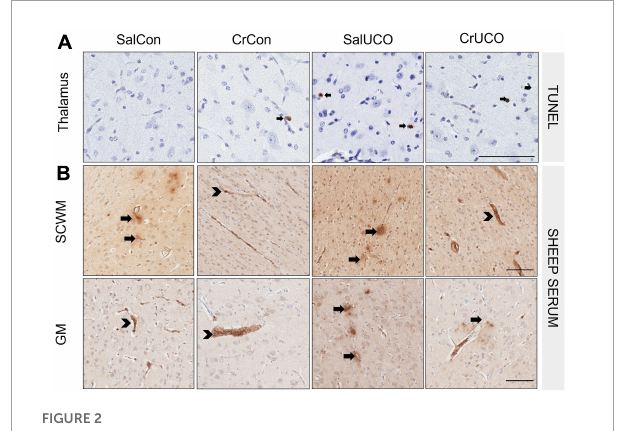
FIGURE2 (A) Representative images of TUNEL-positive cells (black arrows) indicating cell death in thalamus. (B) Representative images of sheep serum extravasation from blood vessels into the brain parenchyma (arrows), and sheep serum contained within the blood vessels (arrowhead) in the subcortical white matter (SCWM) and cortical grey matter (GM). Scale bar represents 100 µ